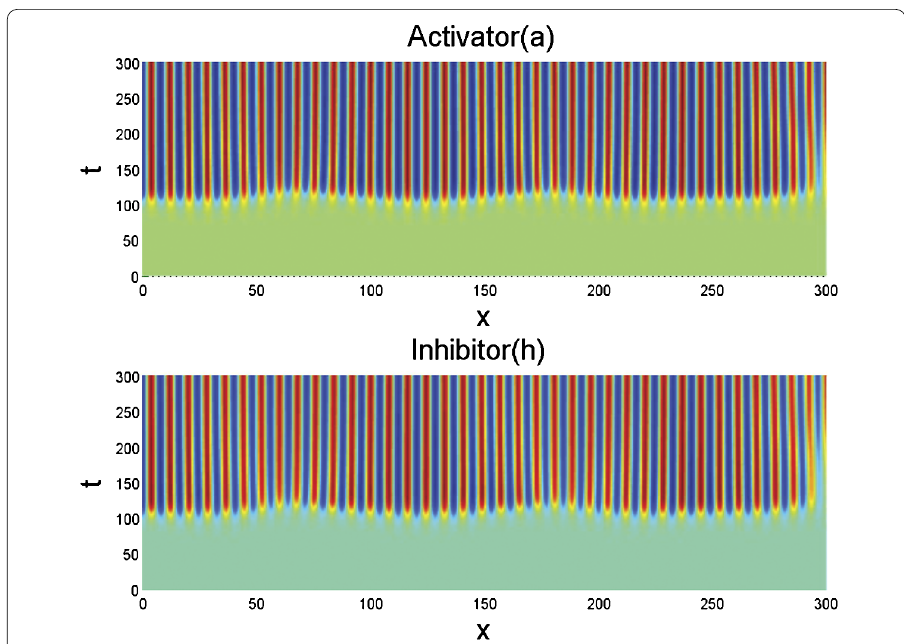
Figure 10 The projection of Fig. 9 in ( x , t )